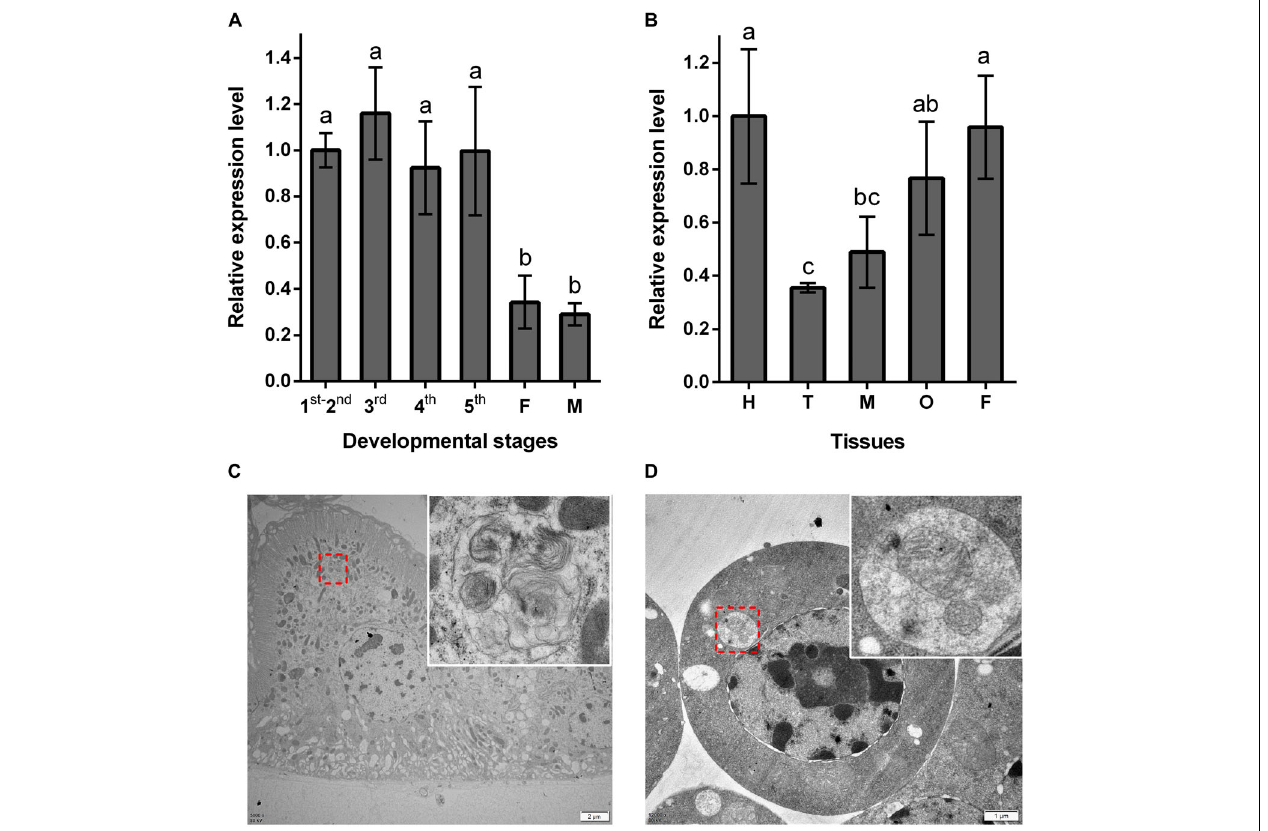
FIGURE 2 | Expression patterns of NlATG1 in BPH. (A) Expression patterns of NlATG1 at different developmental stages. The mRNA level was normalized relative to the RPS11 levels, and the reference was the mRNA level of 1st–2nd instar nymphs. 1st–5th: BPH nymphs from 1st instar to 5th instar, F: female adults, M: male adults. (B) Relative expression of NlATG1 in different insect tissues. H: head, T: thorax, M: midgut, O: ovary, and F: fat body. The reference used was the mRNA level of the head. Relative gene expression was compared by Tukey’s test, for which a, b, and c on the bars indicate significant differences among each